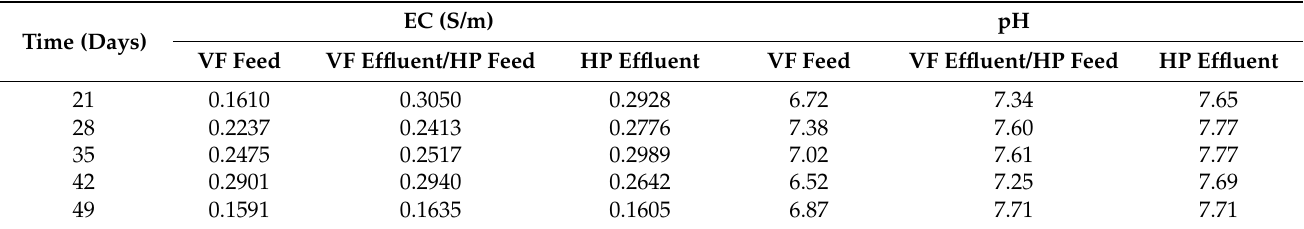
Table 2. EC and pH single readings in the Vermifiltration-hydroponic system. VF: vermifilter; HP: hydroponic unit. Time (Days)